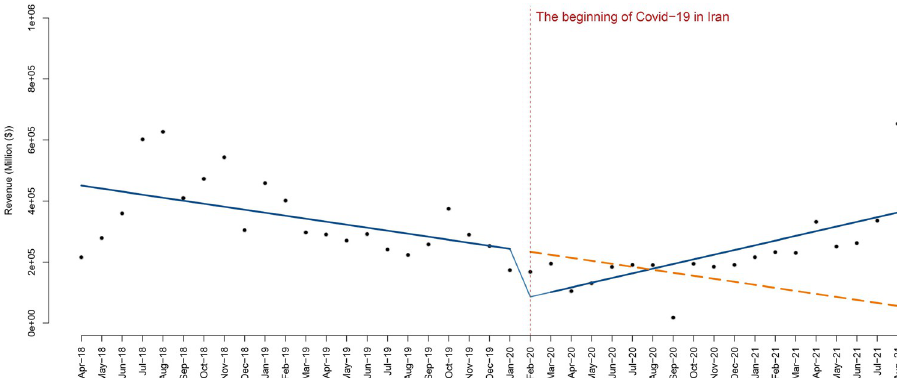
Fig 1. The temporal trend of the revenue rate for public